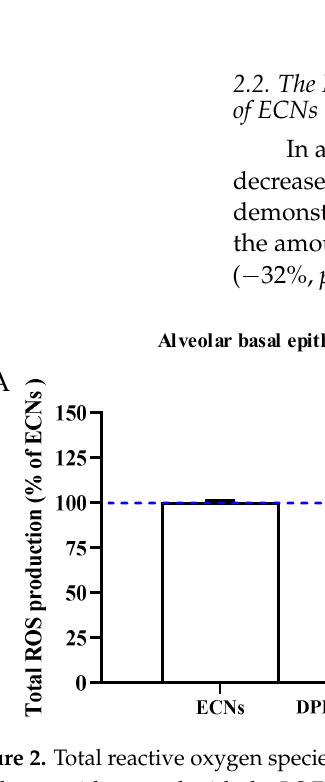
Figure 2. Total reactive oxygen species (ROS) production of A549 ( A ) and BV-2 ( B ) cells following 24 h of ECNs (2 µg/mL) challenge without and with the LS DPPC:POPG(7:3) (indicated as DPPC:POPG(7:3)-ECNs). ECNs = engineered carbon nanodiamonds; DPPC = dipalmitoyl phosphatidylcholine; POPG = 1-palmitoyl-2-oleoyl-sn-glycero-3-phospho-(1′-rac- glycerol). Data are the mean of three independent experiments and are expressed as the percent variation with respect to the total ROS production recorded in ECNs-treated cells. Standard deviations are represented by vertical bars. ** Significantly different from ECNs-treated cells, p < 0.01; *** significantly different from ECNs-treated cells, p < 0.001.